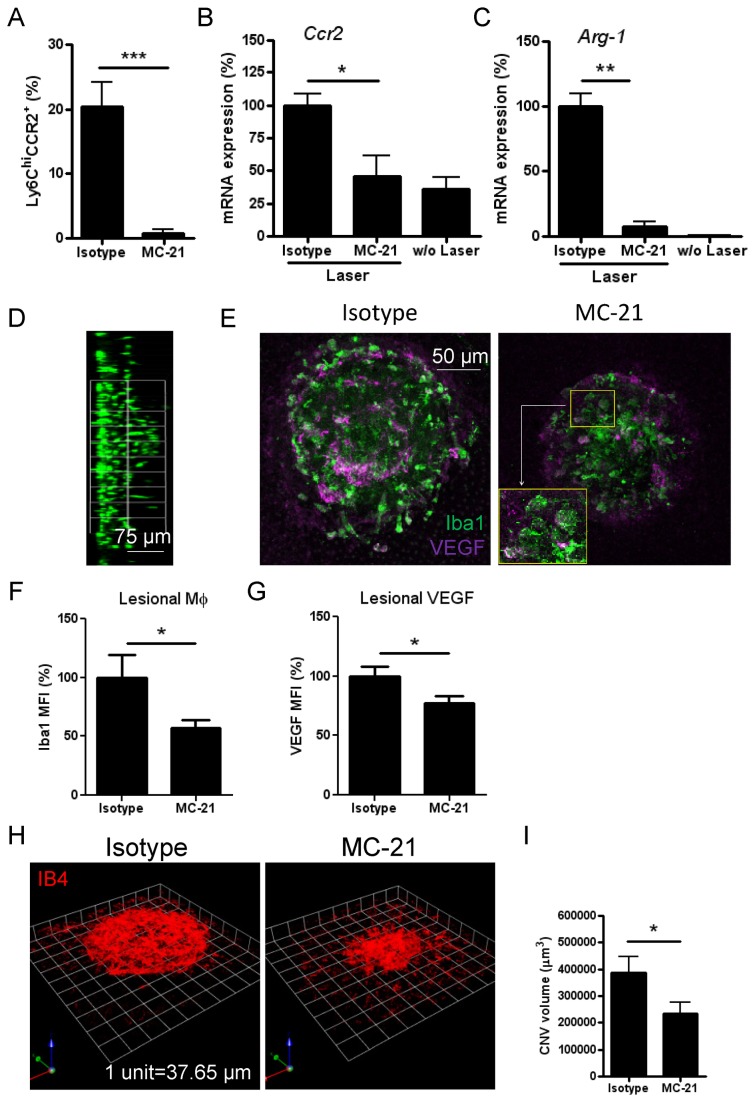
Systemic depletion of CCR2+ monocytes abolishes Arg-1 signature without altering microglia migration, and partly suppresses laser-induced CNV formation.(A) Flow cytometric analysis of peripheral blood from mice following depletion of Ly6C hiCCR2+ monocyte subset using the MC-21 anti-CCR2 mAb, compared with rat IgG2b isotype control (mean ± SEM, n=3). Assessment of Ccr2 (B) or Arg-1 (C) mRNA expression normalised against Gapdh in RPE/choroid day 2 post laser in MC-21 treated mice by QRT-PCR (mean ± SEM, n=4-6). (D) Side view of Z-stacks of confocal images shows migration of retinal microglia (Iba1 staining) in MC-21 treated animals. Confocal images (E) and semi-quantitative mean fluorescence intensity (MFI) analysis using ImageJ software for Iba1+ cell accumulation (F) and whole lesional VEGF expression (G) on RPE/choroid whole-mounts taken on day 2 post laser (mean ± SEM, n≥12/group). Magnification image in (E, inset) shows macrophages co-stained for VEGF in MC-21 injected mice. (H and I) CNV formation on day 7 post laser was assessed by IB4 staining on RPE/choroidal whole-mounts and images were captured by confocal microscopy and analysed using a Volocity® 3D Image analysis software. Representative 3D reconstructions of neovascular complex (H) and quantitative data (I) show reduced CNV volume by 39% with MC-21 treatment compared with control (n=24/group). *
P<0.05; **
P<0.01; ***
P<0.001.